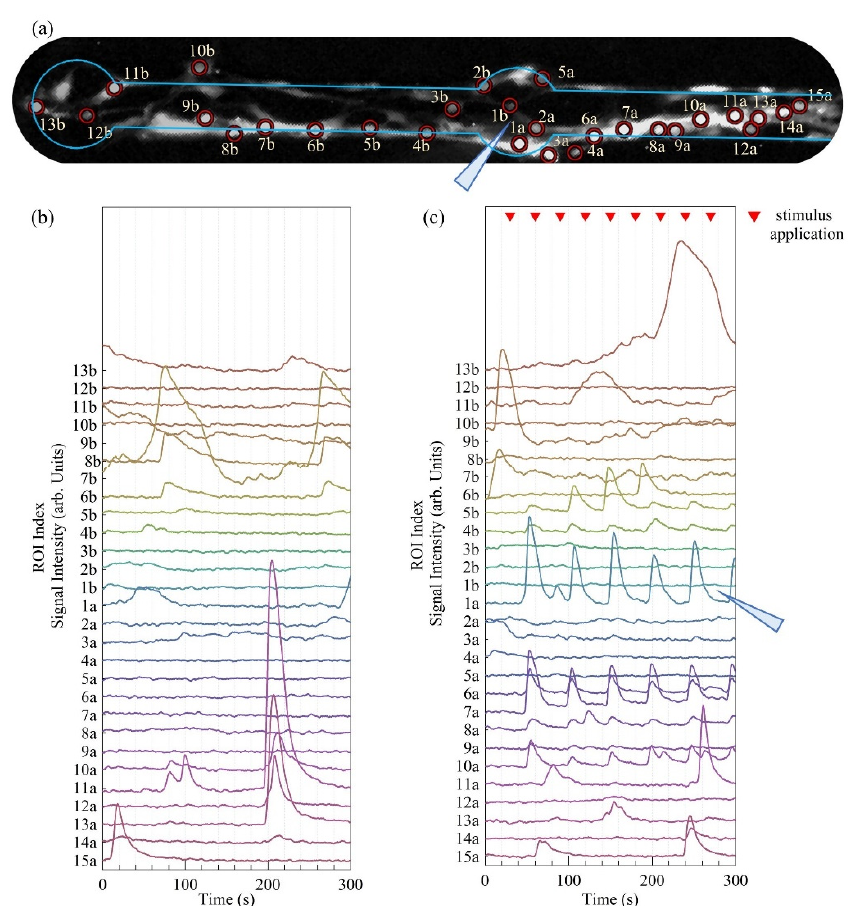
Figure 11. Calcium imaging of astrocytes confined on a micropatterned ns-ZrO x sample. ( a ) Section of a fluorescent image of the calcium signal from astrocytes seeded on a sample patterned with dots of diameter 100 μ m, 500 μ m apart and connected by 50 μ m wide bridges. Only two dots are included in the field of view. The border of the zirconia pattern is highlighted with a blue line. Red circles include each Region of Interest (ROI), corresponding to a cell. The labels report an index to allow the reader to identify the position of the cell with its calcium trace reported in the graphs below. The light blue triangle represents the micropipette delivering the stimulating solution. ( b , c ) Graphs reporting the calcium traces measured from the ROIs reported in image ( a ) when cells are non-stimulated and periodically stimulated with glutamate, respectively. The triangular markers on graph ( c ) indicate the application of the glutamate solution, every 30 s, and the light blue triangle represents the position of the pipette with respect to the cells. The indexes’ number increases for increasing distance of the cells from the pipette tip, and the letters a and b indicate whether cells are of the right or left side of the pipette.